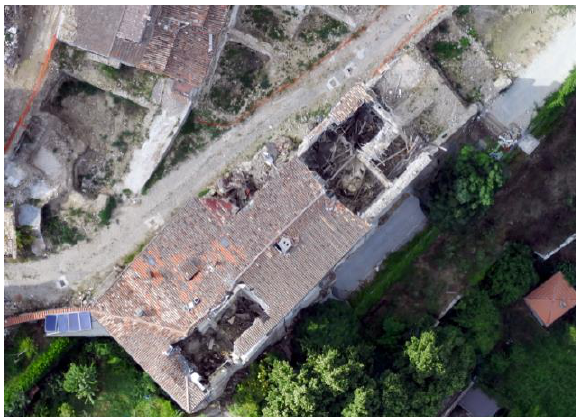
Figure 12. Detail of an earthquake-effected building